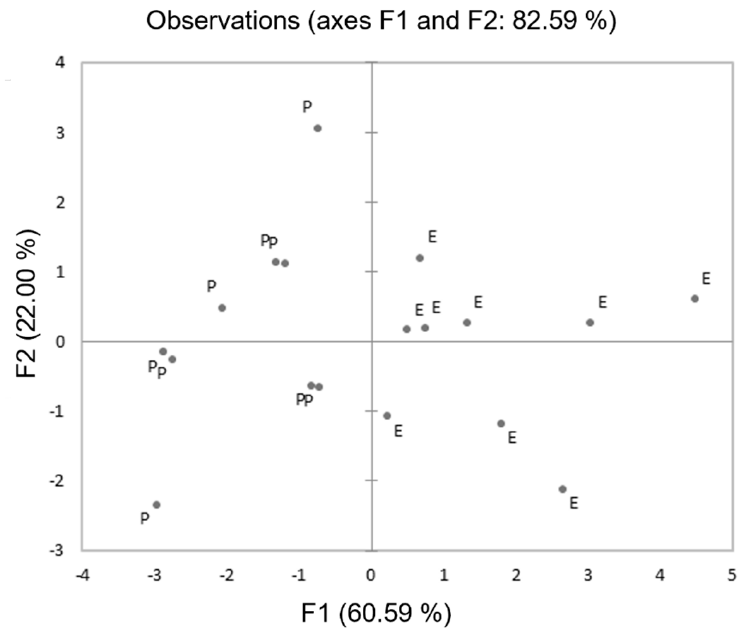
Figure 3. Biplot of the PCA of the two rosemary varieties. P—“Prostatus”, E—“Erectus”.